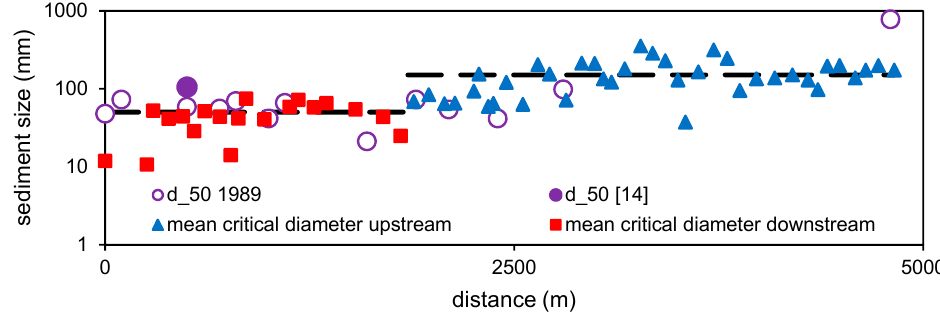
Figure 9. Computed yearly ‐ averaged critical sediment size compared with the median sediment size in the considered reach. Dashed lines identify the reference sizes used in the following computations.